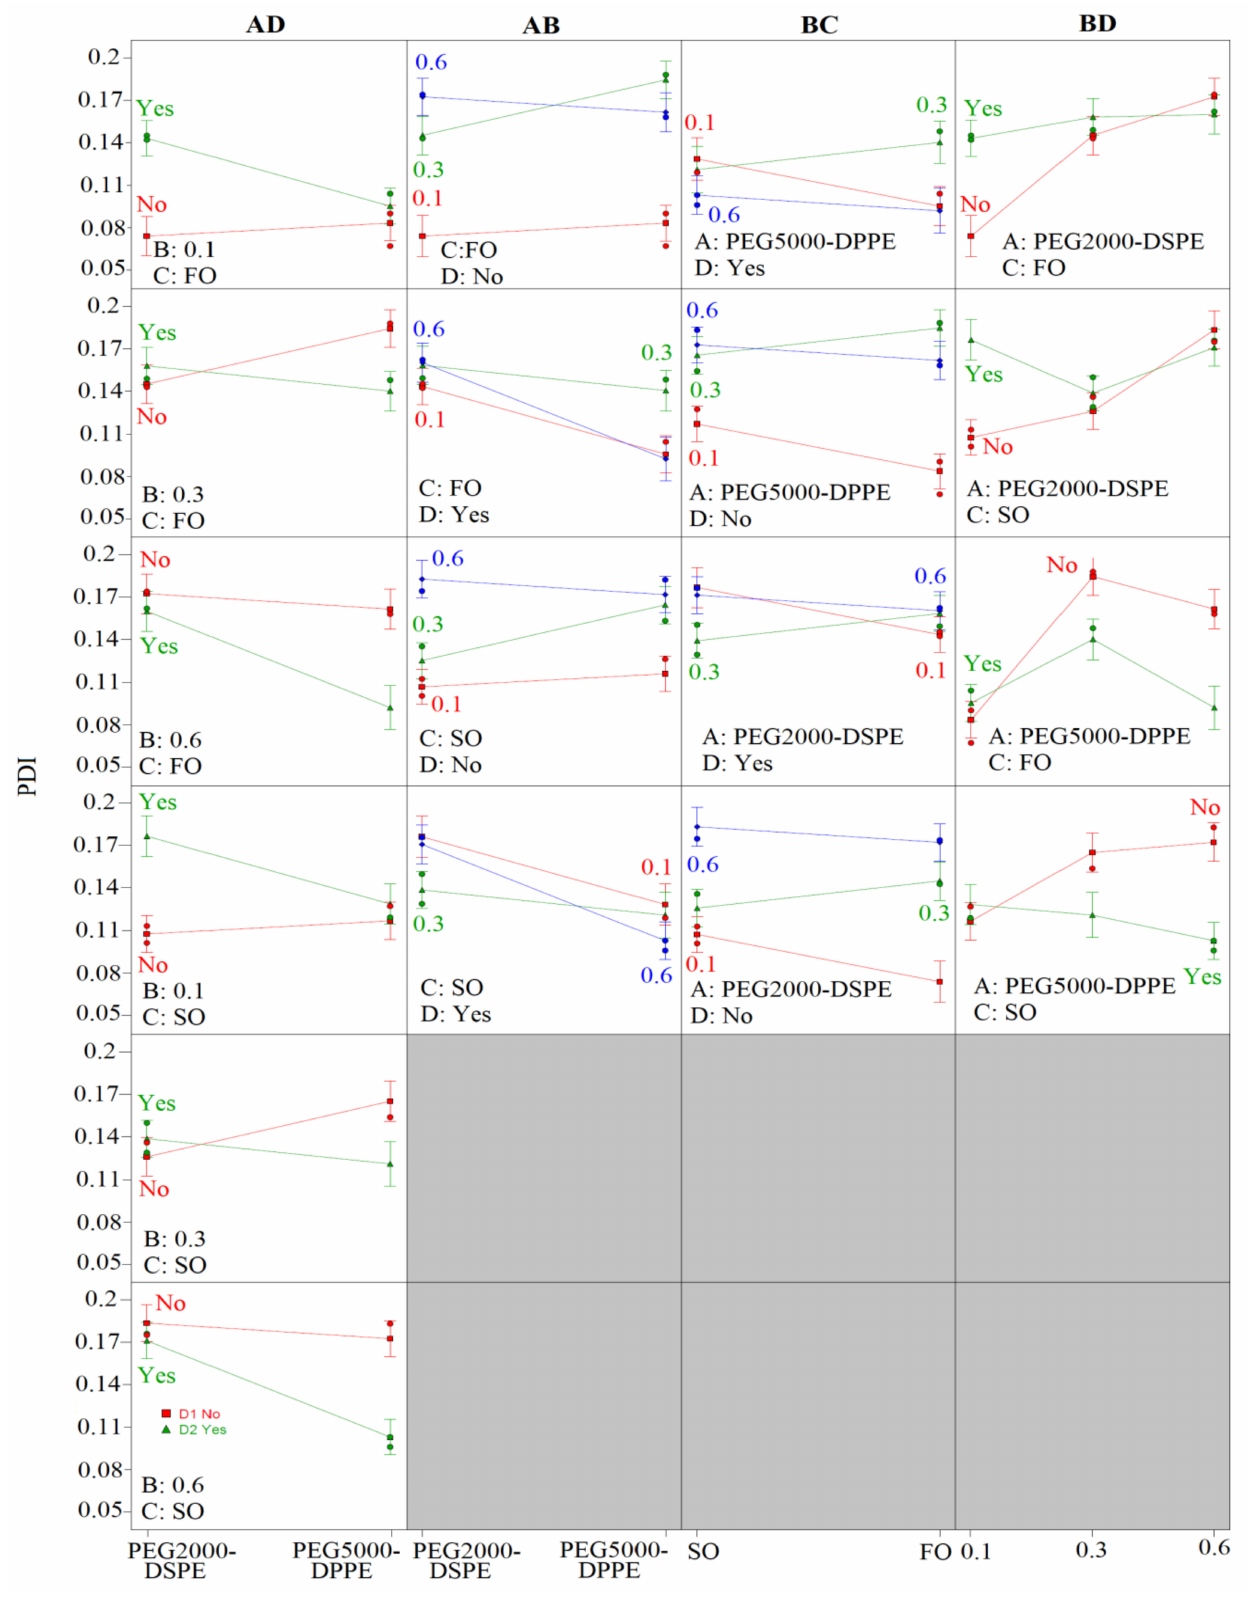
Figure 3. Interaction plot for the polydispersity index (PDI). FO: fish oil; SO: soybean oil. AD—PEG- PL type/presence of curcumin; AB—PEG-PL type/PEG-PL concentration; BC—PEG-PL concentra- tion/oil type; BD—PEG-PL concentration/presence of